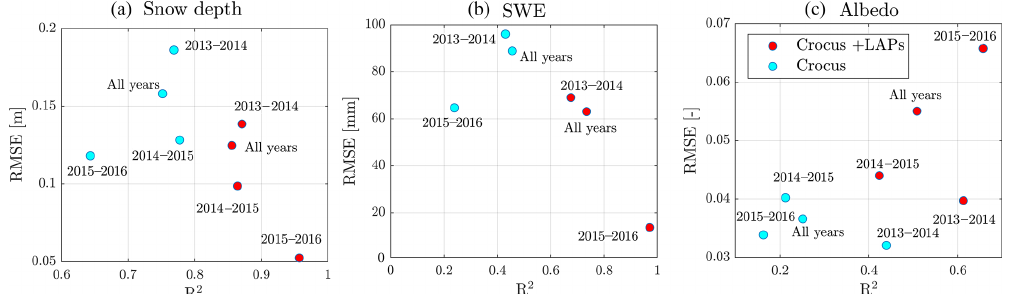
Figure 4. Comparison between (a) snow depth, (b) snow water equivalent (SWE), and (c) albedo observed from the AWS in Torgnon and simulated with Crocus accounting (red dots) and not accounting (cyan dots) for the impact of LAPs on